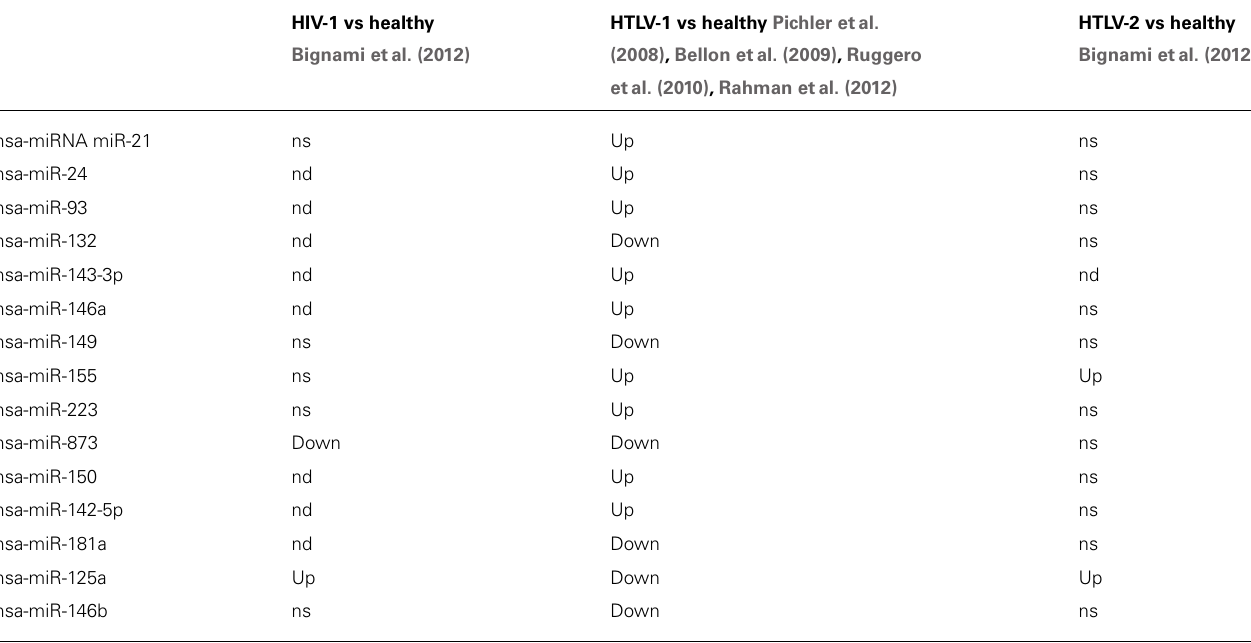
Table 2 | MicroRNAs either up- or down-regulated in HTLV-1 infected cells vs HIV-1 and HTLV-2